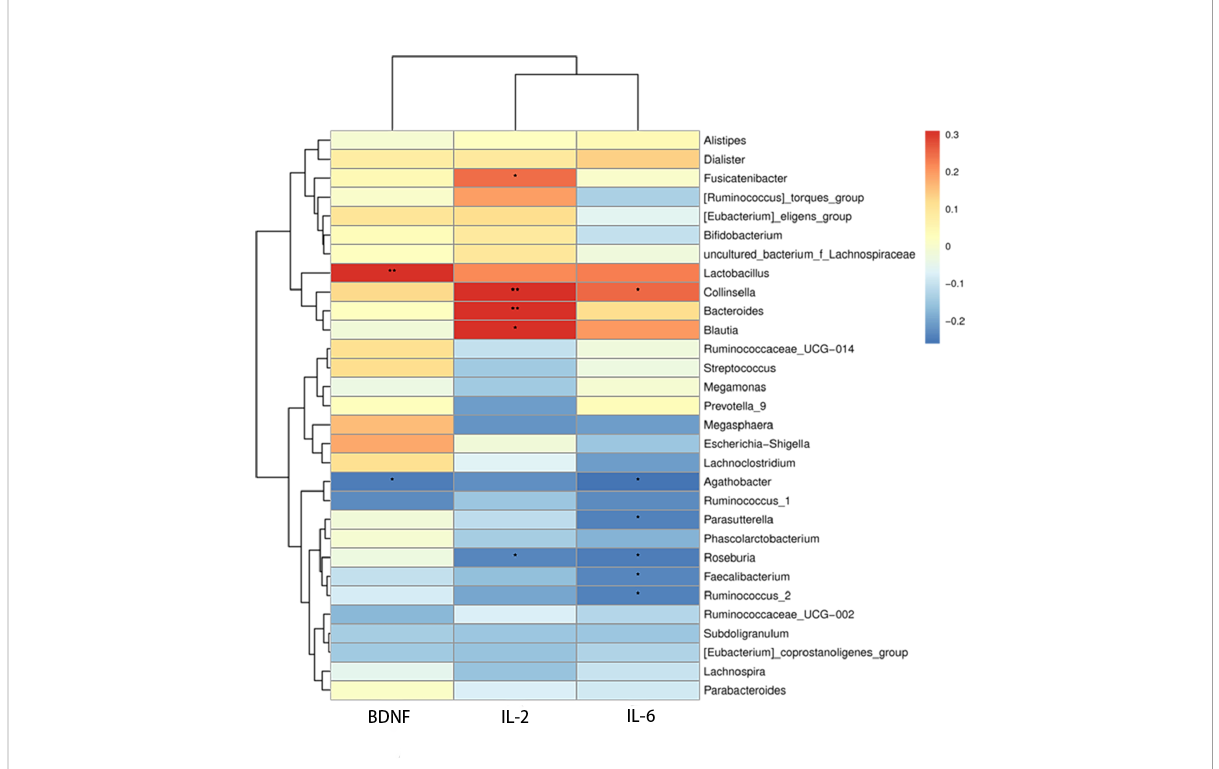
FIGURE 5 Heatmap of correlations between microbial abundances of genera and serum IL-2, IL-6, and BDNF levels, * P < 0.05, ** P <